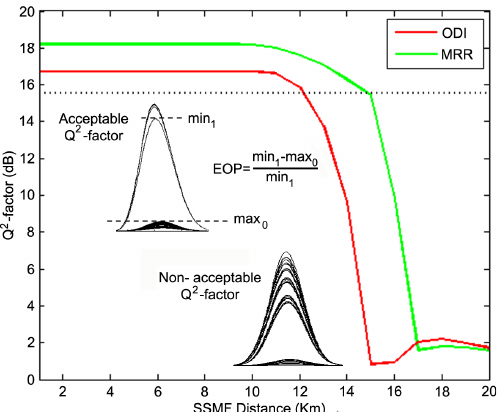
Figure 11. Q 2 -factor vs. standard single-mode fiber (SSMF) distance for ODI (red color) and MRR (green color). The horizontal dotted line denotes the lower limit set for the Q 2